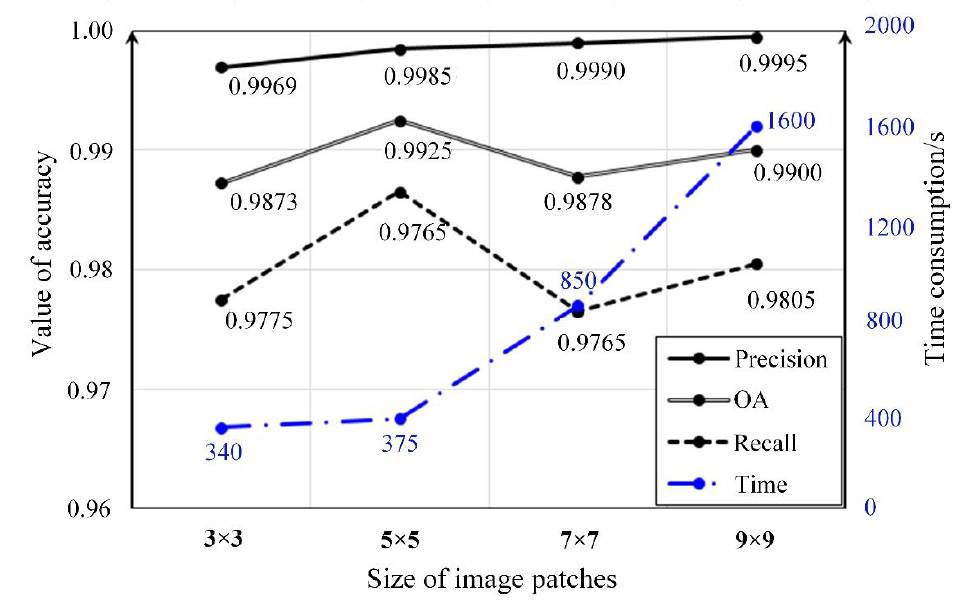
Figure 8. Accuracy and time consumption in testing processes using different sizes of image patch.